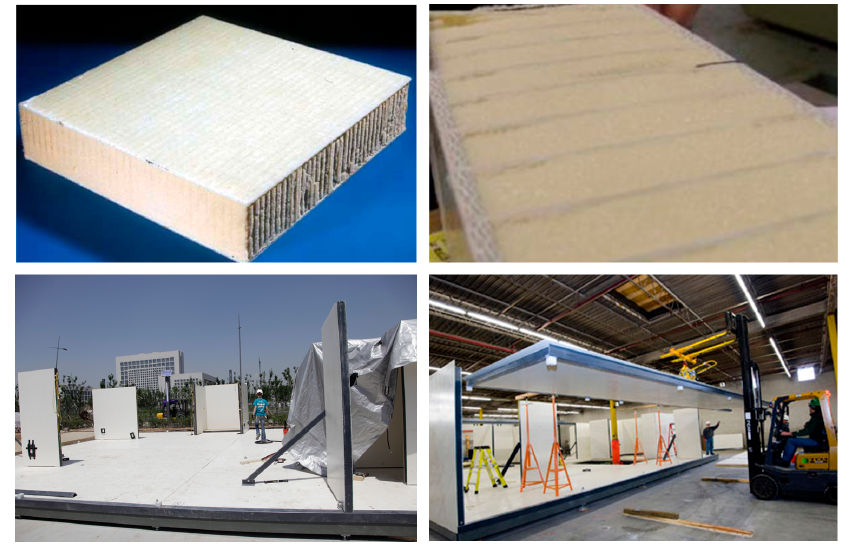
Figure 5. Photos of the FRP Transonite ® panel and their use in the Solar Decathlon project